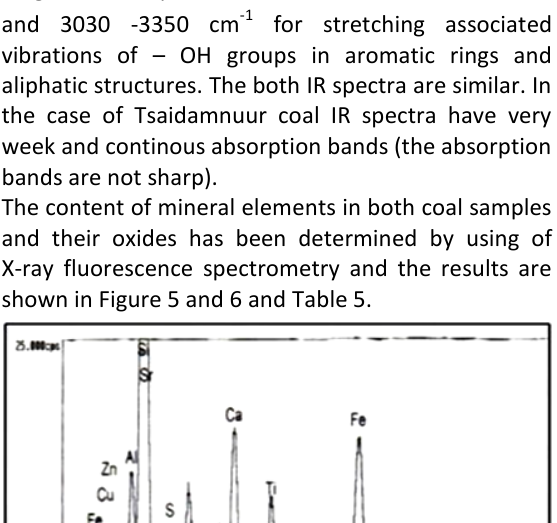
Fig. 3. The IR spectra of coal from borehole IV Fig. 4. The IR spectrum of coal from borehole VIII